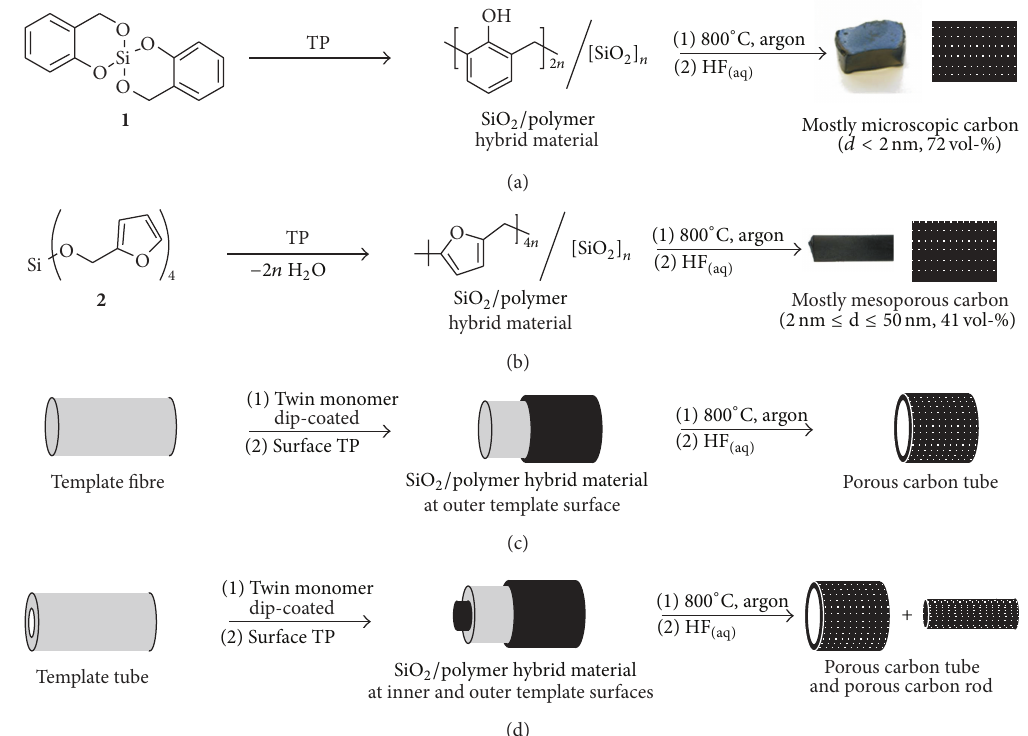
or solution of twin monomer. The coated template was